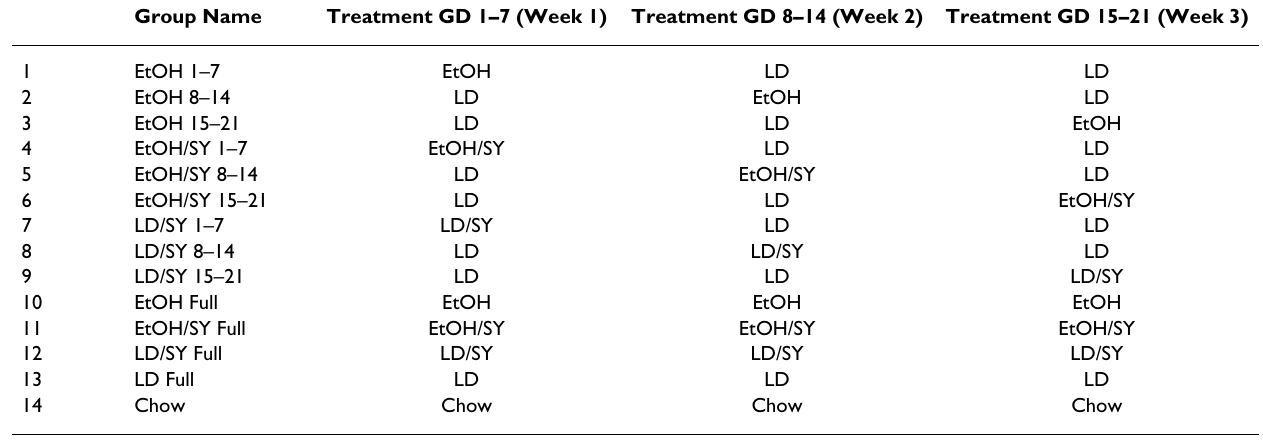
Table 1: Experimental Group Treatment Per Week Over the Three-Week Gestation Period. Group